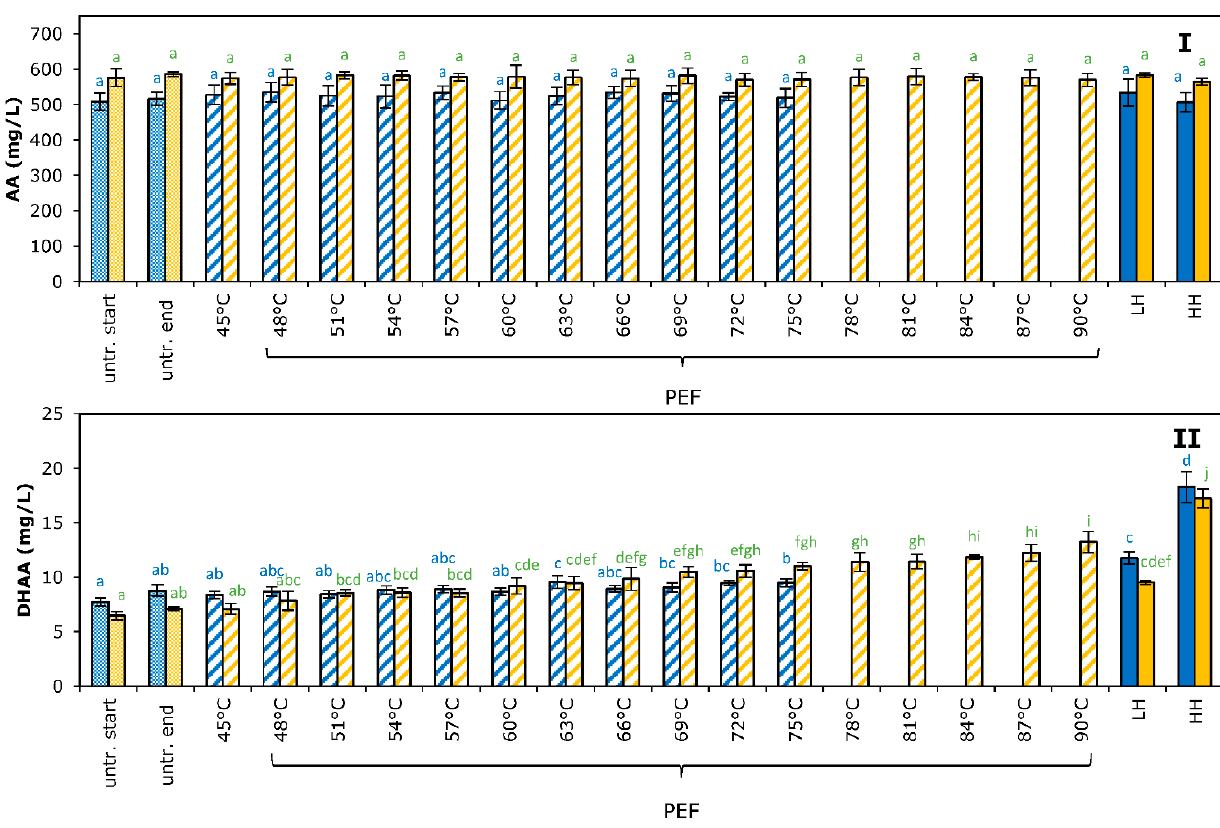
Figure 3. Effect of PEF and thermal processing on ascorbic acid (AA) (panel ( I )) and dehydroascorbic acid (DHAA) (panel ( II )) concentration in orange juice. Blue bars represent juice A, orange bars represent juice B. Values of untreated juice at start and end of the day are given. Results of various moderate intensity PEF treatment are given according to the maximum temperatures applied, using an E = 2.7 kV/cm (blue bars) and 0.9 kV/cm (orange bars). Thermal treatments are indicated as LH for low heat treatment (75 °C—20 s) and HH for high heat treatment (95 °C—20 s). Bars represent the average of three measurements with standard deviation. Statistical differences between the treatments are indicated with a letter per juice (color), with matching letters showing no significant difference.